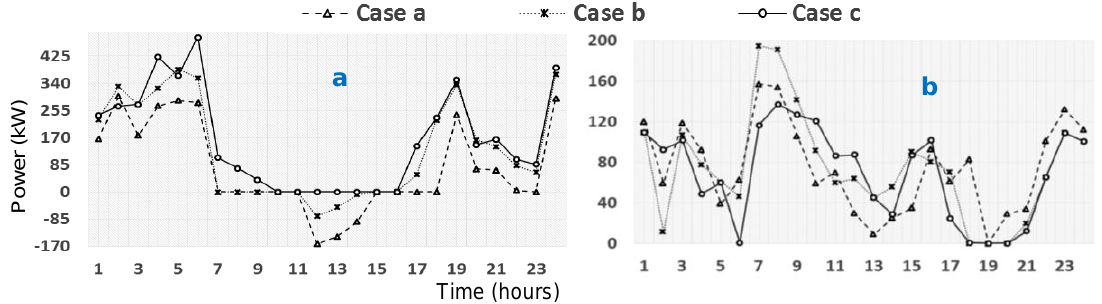
Figure 11. Collective power trading in grid connected mode: ( a ) Internal trading; and ( b ) External trading.